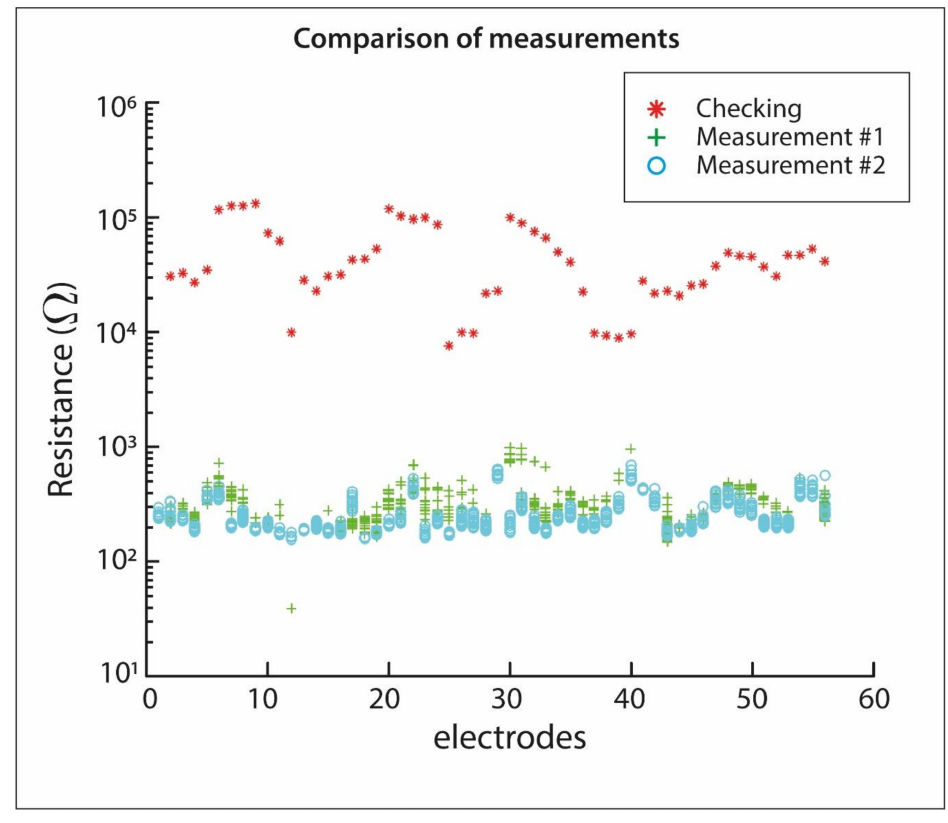
Figure 5. Ground-electrode resistance values at each passive electrode, in which values labelled with a red star symbol are from checking measurements, before using gel, and those values, represented by blue and cyan symbols, are from measurements #1 and #2, after using